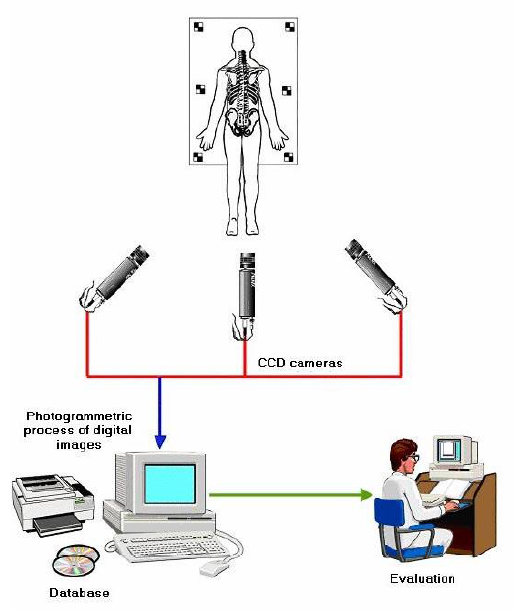
Figure 11. The proposed three-camera system followed by software analysis; Source: (Patias et al.,